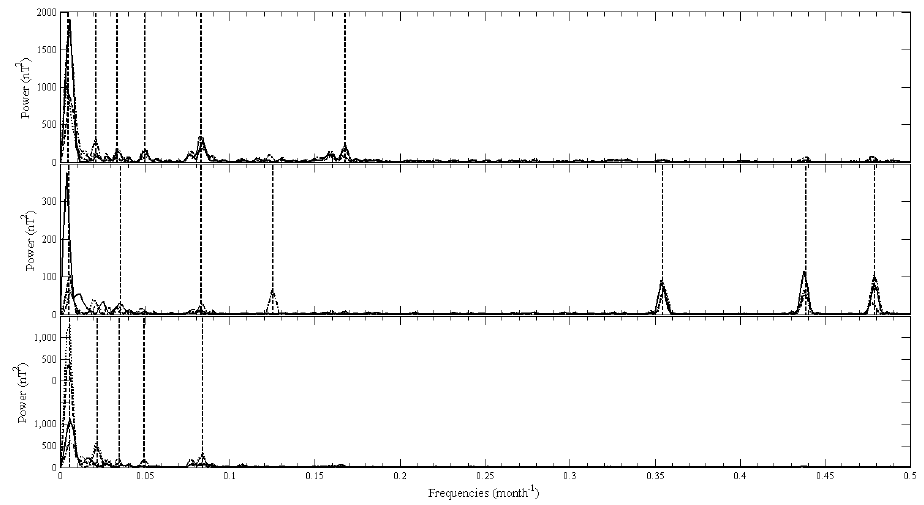
Figure 15. Power spectrum of X. Y, Z - components of external contribution (POMME-9 model) at different observatories: NGK (dotted line), FUR (dashed line), KAK (dash-dotted line) and HER (solid line).